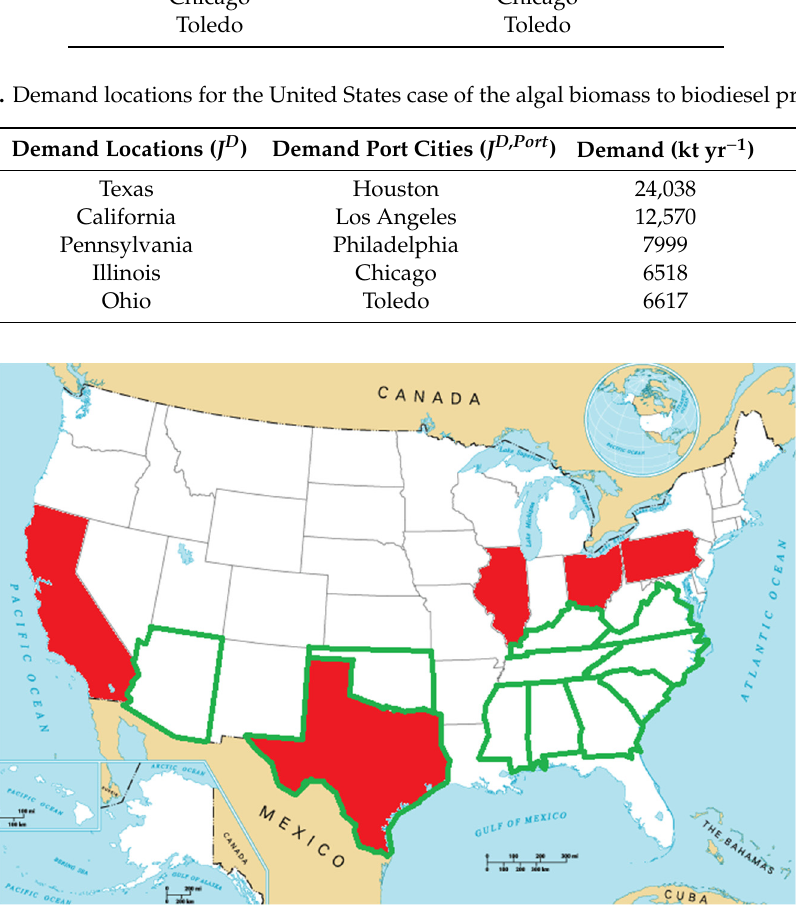
Charleston Table 4. Extraction and transesterification locations for the United States case of the algal biomass to biodiesel problem. Extraction Locations (𝑱 𝑬𝒙 ) Transesterification Locations (𝑱 𝑬𝒔 )